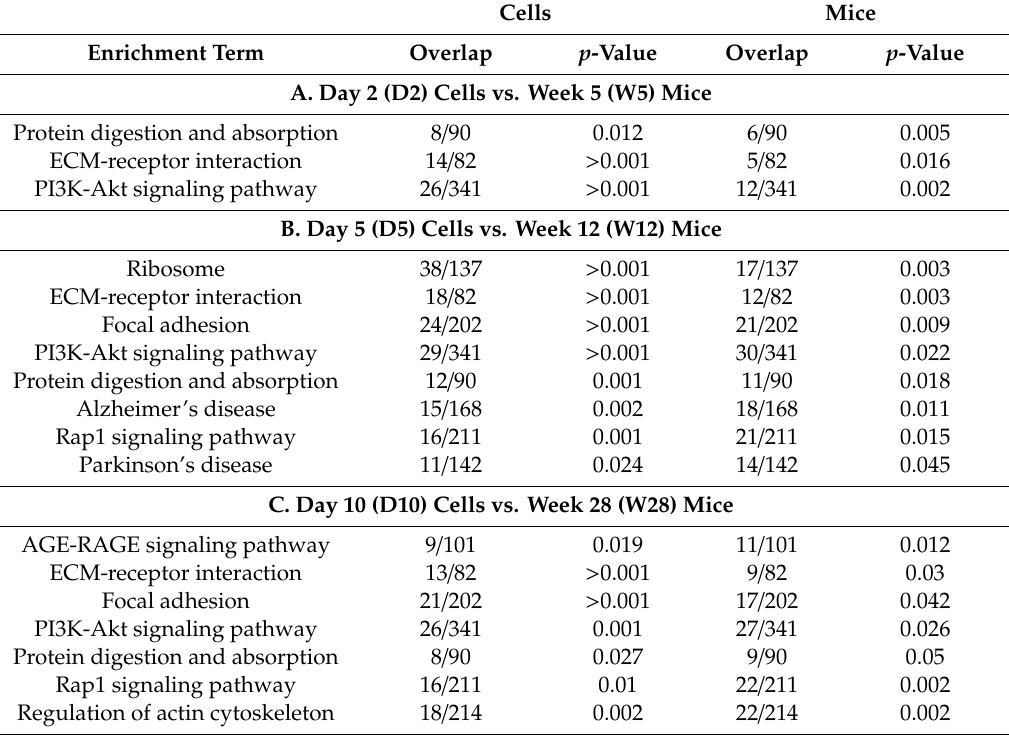
Table 1. Common dysregulated pathways in cells and mice at matched time-points associated with protein